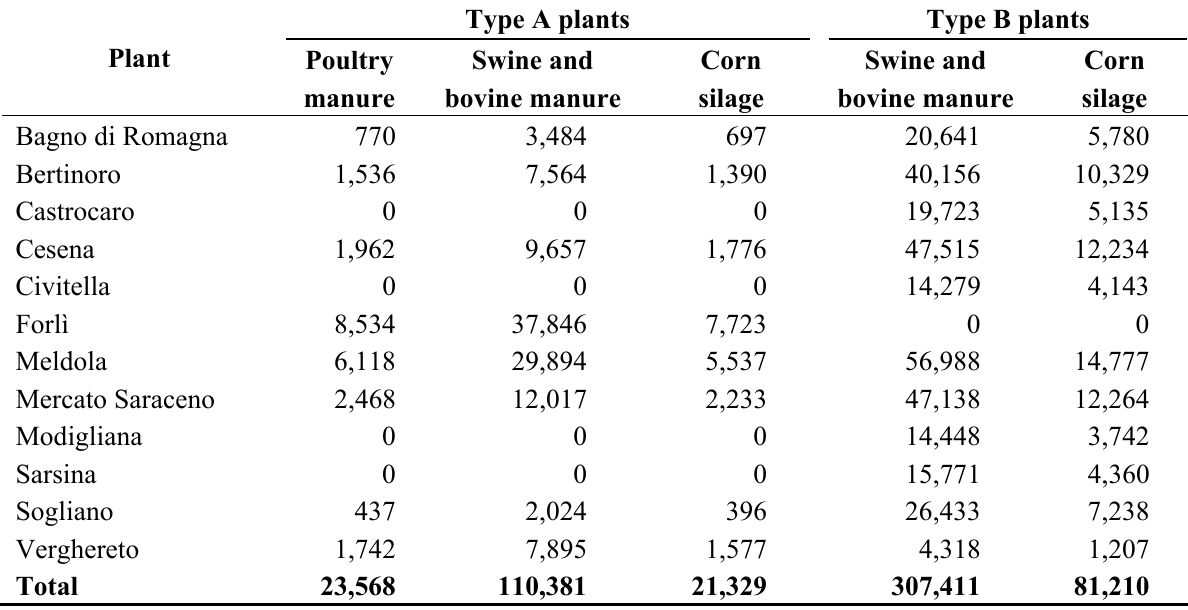
Table 11 details the solution in terms of biomass utilization in the two types of plants. Of the 12 parcels where a plant can be built, four can have only a type B plant and one only a type A. Overall, about one fourth of the swine and bovine manure is used in type A plants (which means again the type B is prevailing) and the operation of the entire network requires about 102 Gg of corn silage. Table 11. Subdivision of available feedstock for plant types (all values in wet Mg/year). Type A plants Type B Plant